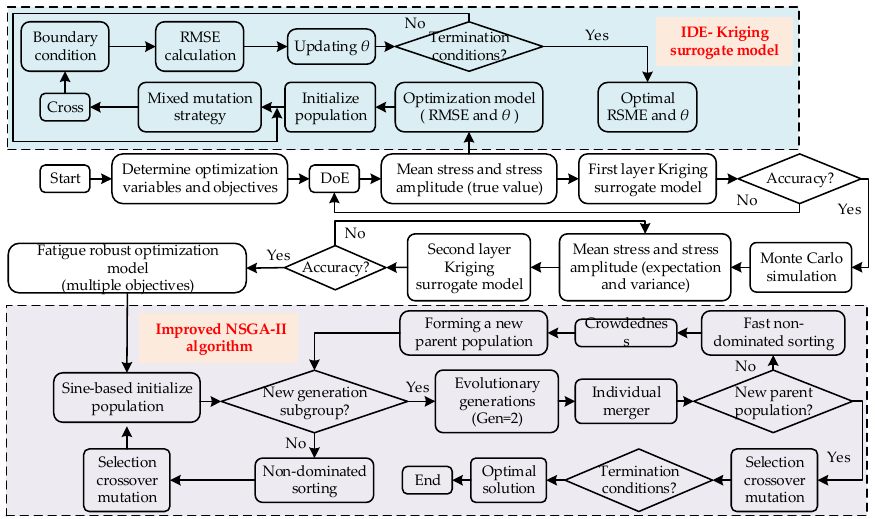
Figure 16. Robust fatigue optimization process based on the double-layer Kriging surrogate